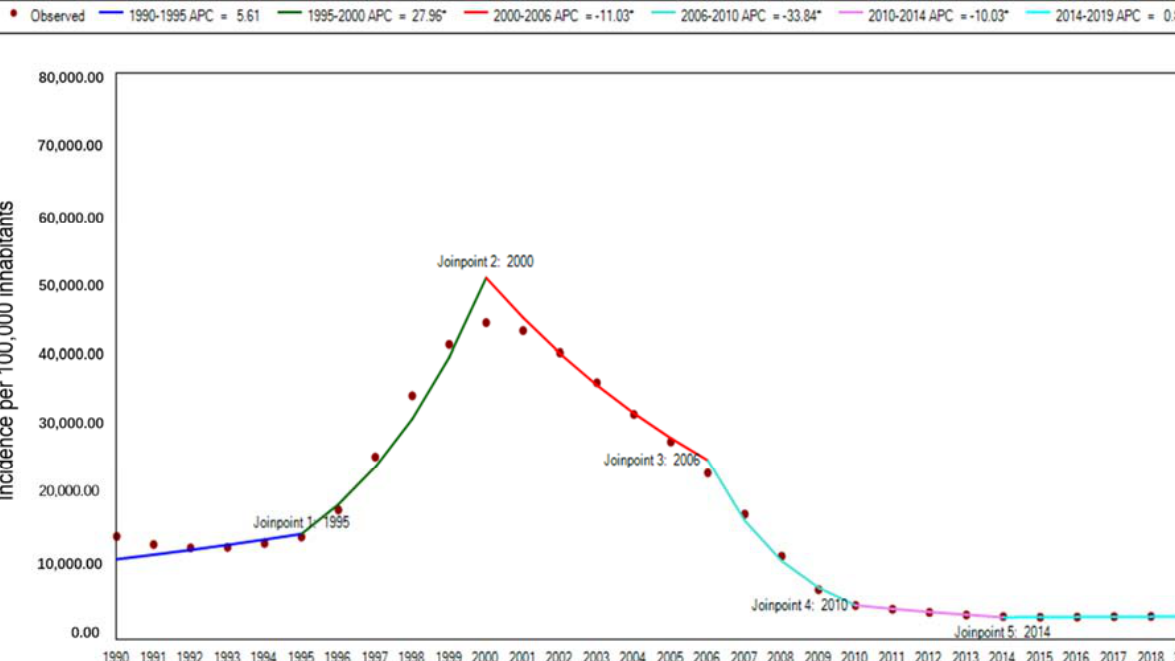
Figure 1. The trend of age ‐ s tandardized incidence rates for malaria in STP, 1990–2019. Note: * indi ‐ cates p < 0.05.